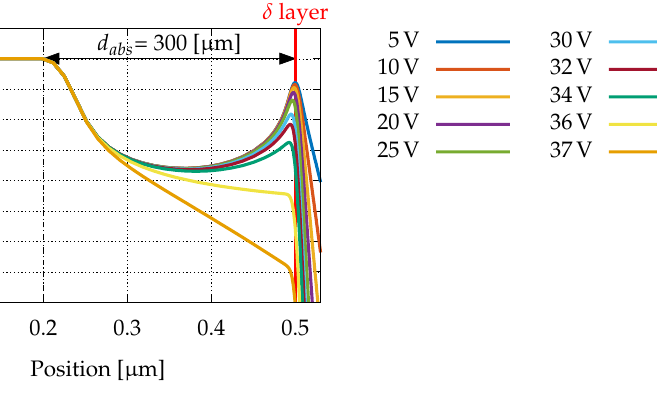
Figure 9. Simulated conduction band profile for different reverse